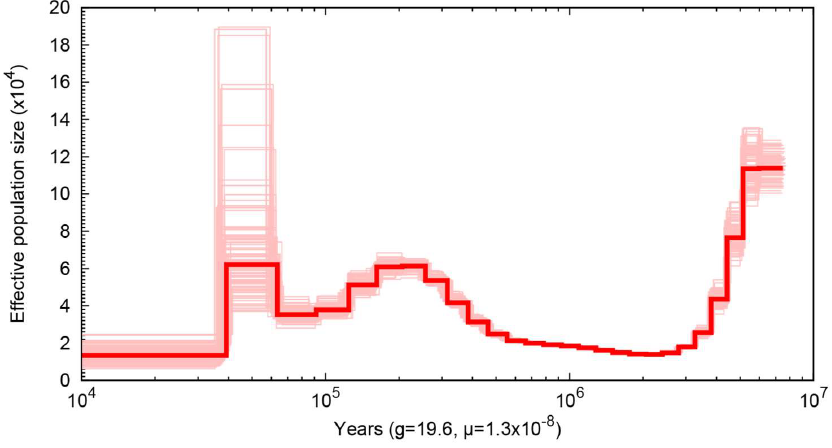
Figure 4. Demographic history of S. bredanensis , constructed using the PSMC.